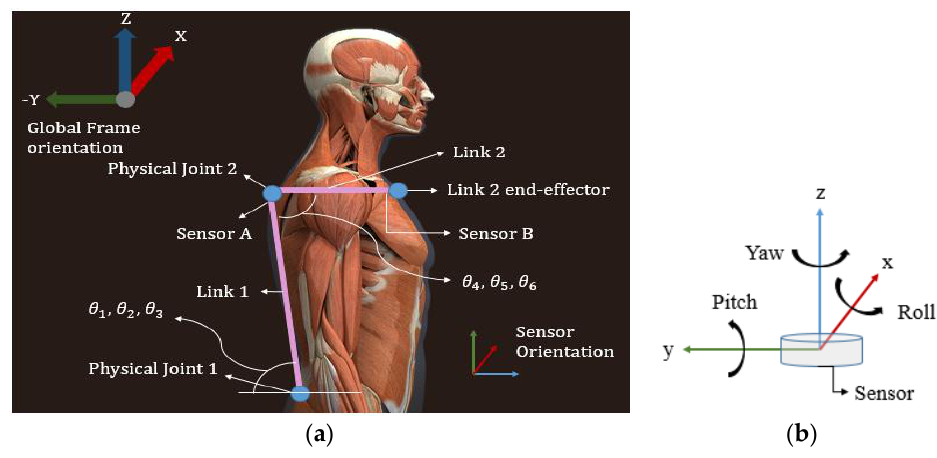
Figure 2. Sensor placement: ( a ) Shows location of joints of robot model along with placement of sensors. Both the physical joints are imaginary. Physical Joint I is located at the hip (hip joint), and Physical Joint II is located on the back (posterior side), just below the neck. Each physical joint has 3-DOF (degree-of-freedom) (three joints are combined to form each Physical Joint) imparting the robot system a total of 6-DOF. Links 1 and 2 are also imaginary and connect Physical Joint I to Physical Joint II, and Physical Joint II to Link 2 end-effector, respectively. Sensor A is placed at the end of Link 1 just before the Physical Joint II and, thus, it gives the orientation of Link 1 with respect to the global frame. Sensor B is placed at the end of Link 2 just before the Link 2 end-effector, and it gives the orientation of Link 2 with respect to the global frame. θ 1 , θ 2 , θ 3 are the angles that Link 1 makes with the base frame (Frame 0) of the robot model that will be introduced ahead. θ 4 , θ 5 , θ 6 are the angles that Link 2 makes with Link 1 and are found to provide the respiratory information; ( b ) The orientation of both sensors: ‘Roll’ is the rotation around “x-axis,” “pitch” around “y-axis” and “yaw” around “z-axis” of the sensor coordinates. All rotations follow anticlockwise-positive